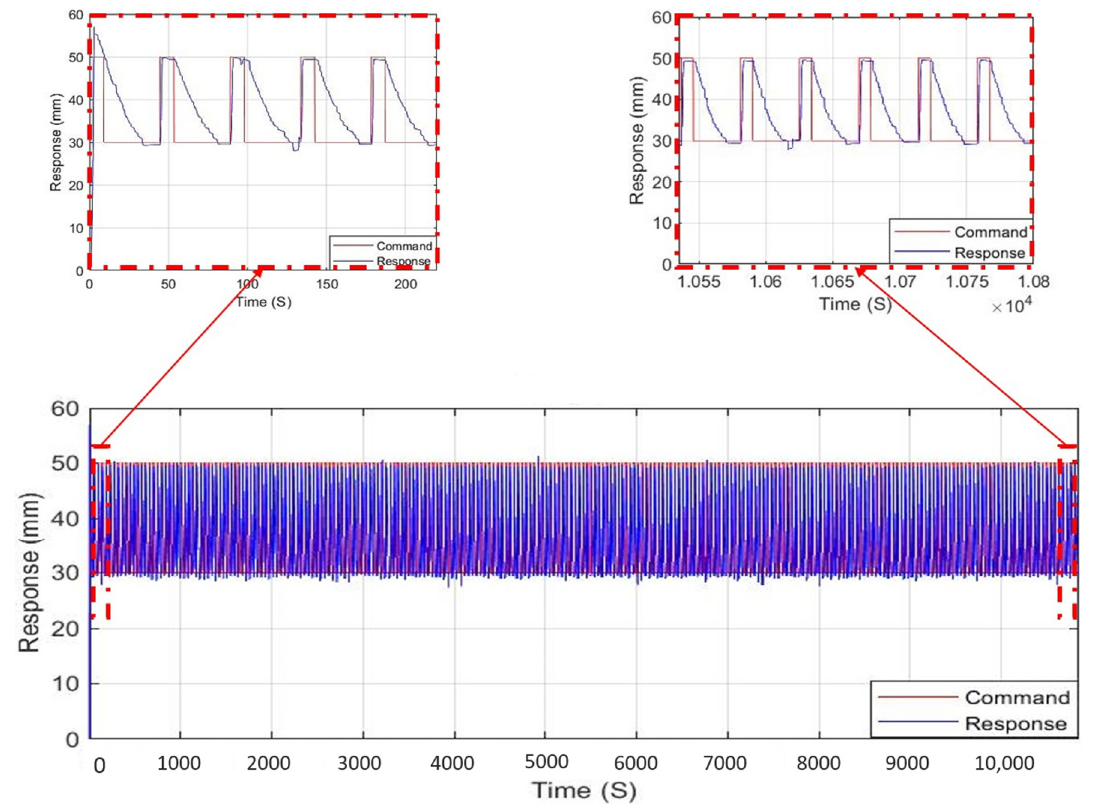
Figure 15. Displacement lifecycle test results.